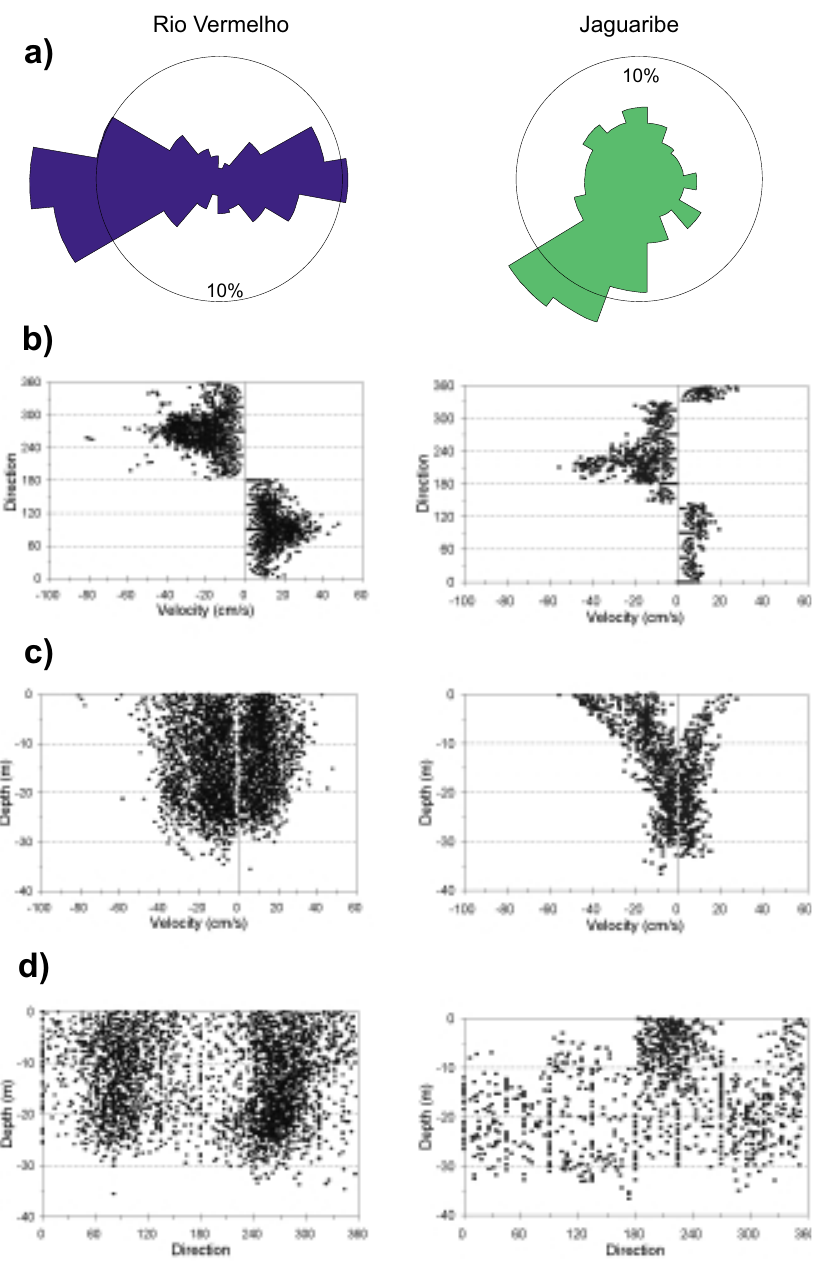
Fig. 5 – Frequency distribution of the tidal-current directions at Rio Vermelho and Jaguaribe, and a velocity direction plot of all data showing i) a strong bimodal (tidal) distribution in RioVermelho and ii) the predominance of a stronger southwest current in both locations. Negative velocities are associated with westward flows in Rio Vermelho and southwestward flows in Jaguaribe. The results derive from 12 intermittent tidal cycles from Rio Vermelho and 4 intermittent tidal cycles in